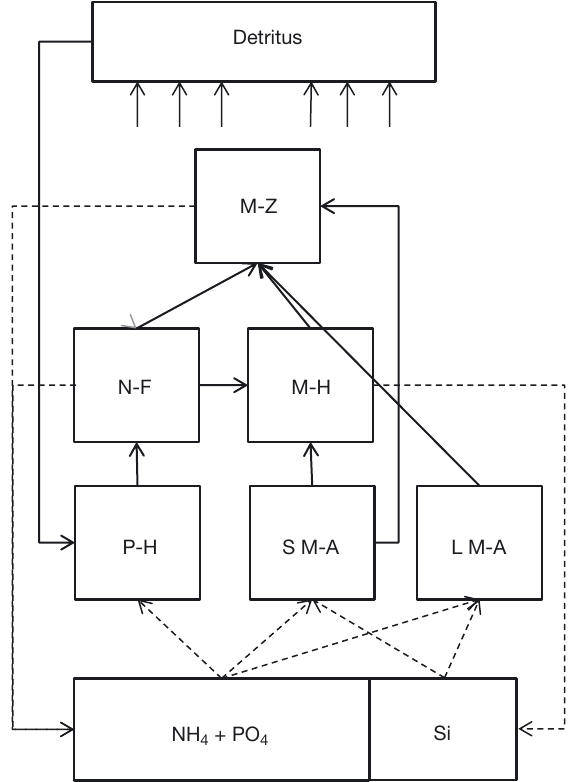
Fig. 1. Carbon biomass compartments of the plankton func- tional groups studied: small and large micro-autotrophs (S M-A and L M-A), pico-heterotrophs (P-H), nanoflagellates (N-F), micro-heterotrophs (M-H), meso-heterotrophs, i.e. zooplankton (M-Z), and detritus. Solid lines denote the main carbon flows, and dashed lines show the flow of all inorganic nutrients: ammonium (NH 4 ), phosphate (PO 4 ), and silicon (Si). Detritus is produced by the whole food web